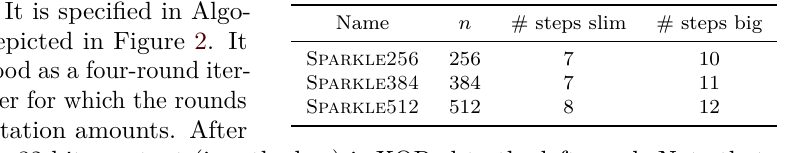
denotes the 64-bit input ( 𝑥 𝑖